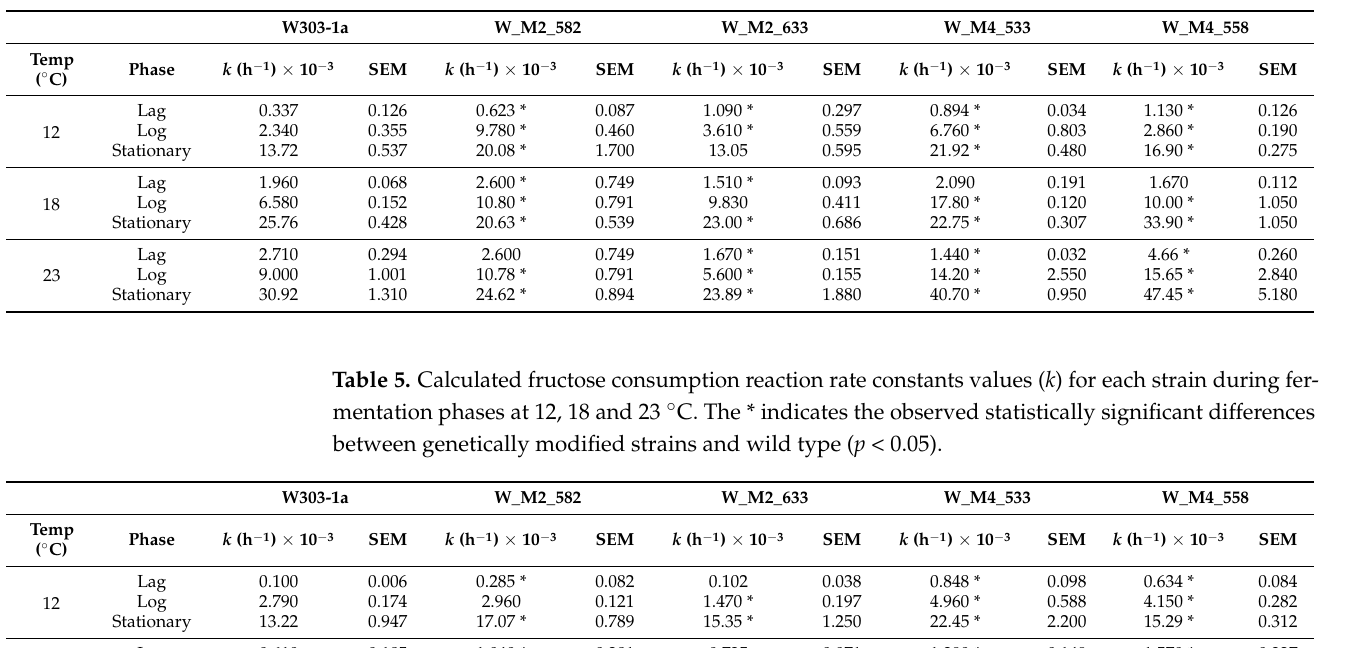
Table 4. Calculated glucose consumption reaction rate constants values ( k ) for each strain during fer- mentation phases at 12, 18 and 23 ◦ C. The * indicates the observed statistically significant differences between genetically modified strains and wild type ( p < 0.05).